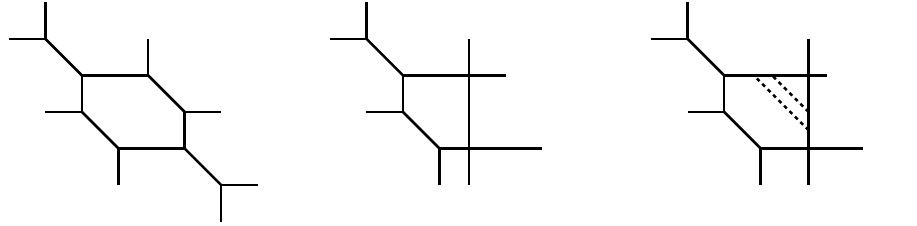
Figure 1 . The figure on the left is a ( p, q ) -web diagram that engineers a SU(2) SQCD, which can be constructed by gluing two strip geometry. In the middle figure, the Coulomb branch parameter has been tuned to special values corresponding to the root of the Higgs branch, where some NS5 branes and D5-branes are aligned reconnected. In the figure on the right, the NS5-brane on the right is pulled away of the web while suspending some D3-branes (represented by the dashed lines) which engineer codimension-two defects in the remaining 5d theory, which is a free theory with 4 fundamentals in this